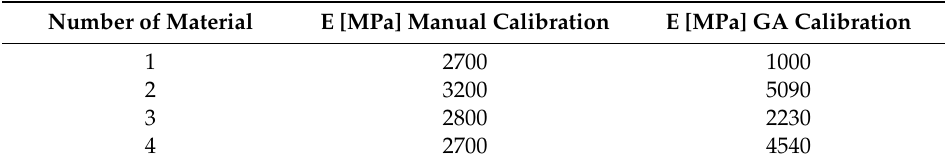
Table 5. Young’s Modulus values (E, MPa). Di ff erences between the manual calibration and the Genetic Algorithms (GA) calibration for the step